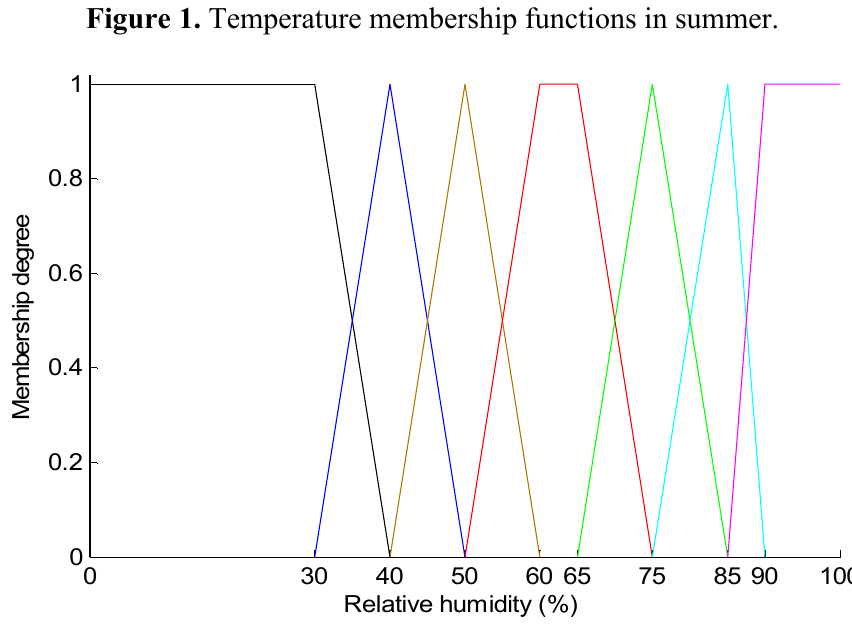
Figure 2. Relative humidity membership